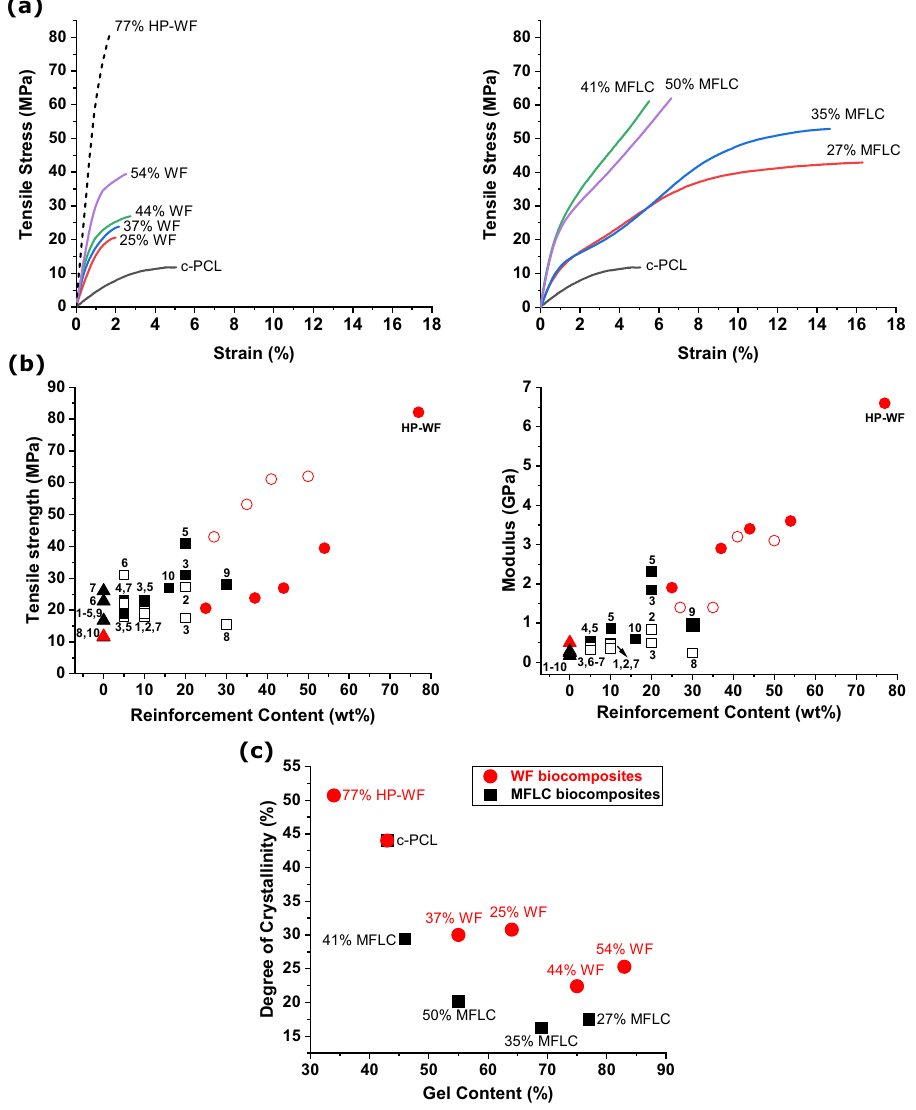
Fig. 4 | Mechanical properties of the biocomposites at various reinforcement contents,togetherwithinformationonthecrystallinityandgelcontentofthe polymer matrix. a stress-strain curves of wood fi bers (WF) and micro fi brillated lignocellulose (MFLC) reinforced crosslinked polycaprolactone (c-PCL) compo- sites. b Ultimate tensilestrength and modulus versus lignocellulose reinforcement content in c-PCL composites. Square symbols: literature data from references 1: 67 ,